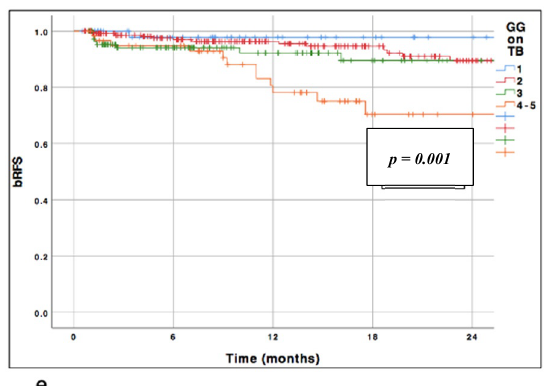
Figure 2. Biochemical recurrence free curves stratified by MRI characteristics. ( a ) Biochemical recurrence free curves stratified by PI-RADS. Log rank test p = 0.006. ( b ) Biochemical recurrence free curves stratified by IRM extracapsular extension. Log-rank test p = 0.004. ( c ) Biochemical recurrence free curves stratified by number of MRI lesions. Log-rank test p = 0.912. ( d ) Biochemical recurrence free curves stratified by MRI lesion diameter. Log-rank test p = 0.009. ( e ) Biochemical recurrence free curves stratified by grade group on targeted biopsy. Log-rank test p = 0.001. bRFS = biochemical recurrence free survival; iECE = extracapsular extension on MRI; MRI: magnetic resonance imaging; Nb MRI lesions = number of MRI lesions; GG on TB = grade group on targeted biopsies; PI-RADS: prostate imaging and reporting and data system.